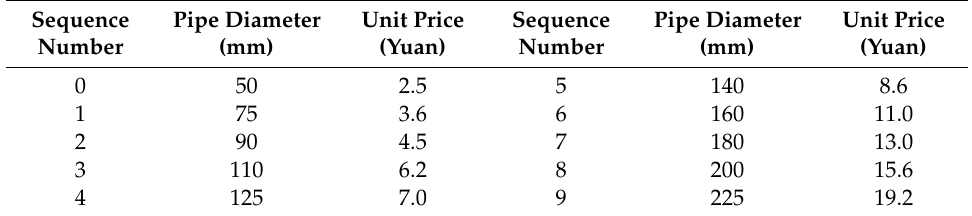
Table 5. Unit prices of pipes with di ff erent diameters.